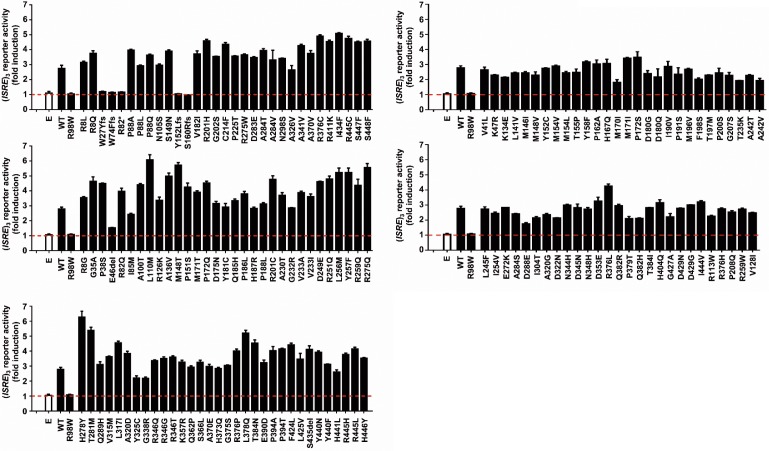
Functional impact of IRF4 variants previously reported in gnomAD database.Luciferase activity of HEK293T cells cotransfected with an (ISRE)3 reporter plasmid plus the pcDNA3.1 empty vector (E) and plasmids encoding IRF4 WT, IRF4 R98W or several IRF4 variants previously reported in the gnomAD databases (see Figure 3). Results are shown as the fold induction of activity relative to E-transfected cells. The red dotted line represents the mean fold induction in E-transfected cells. The results shown are the mean ± SD of at least two independent experiments.